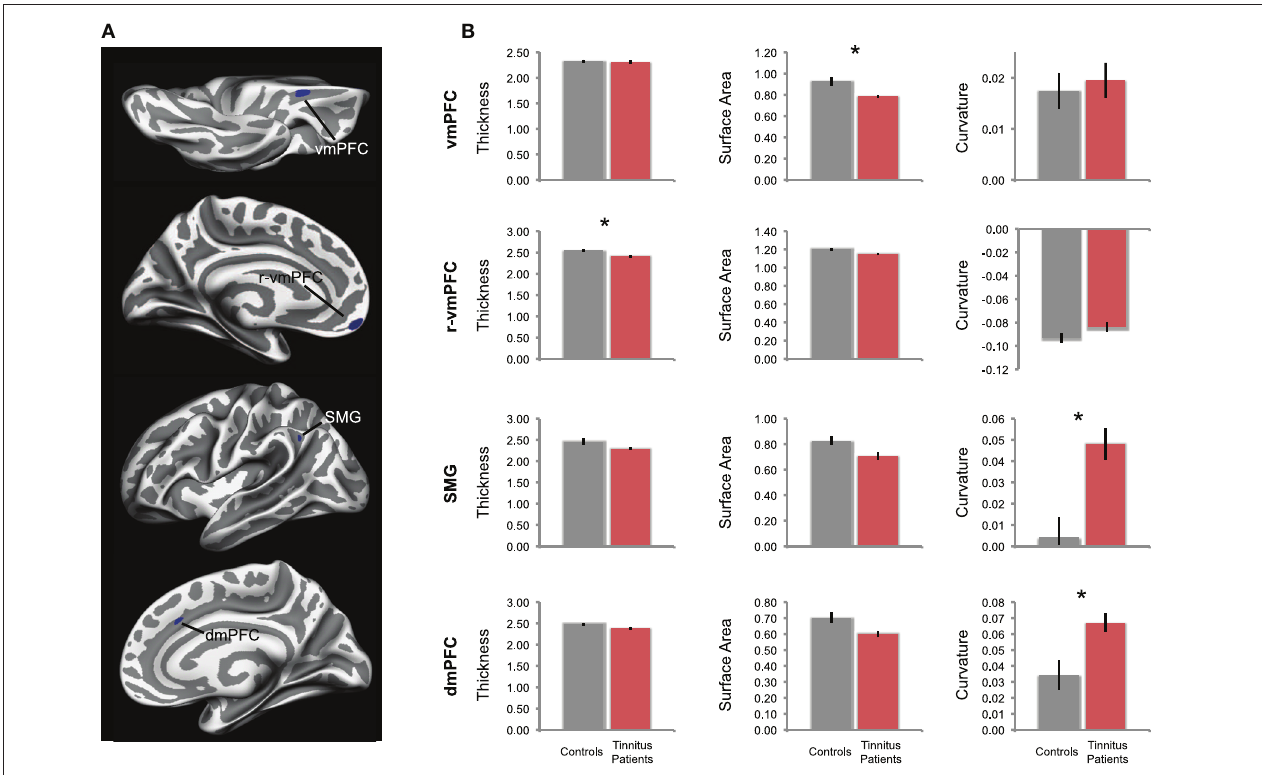
each cluster in (A) , the mean values of morphological features are plotted, including cortical thickness, surface area, and gyrification (curvature) for each group. For gyrification, positive values indicate sulci, negative values indicate gyri. Tinnitus patients are plotted in red; control participants are plotted in gray. Error bars represent standard error, and asterisks denote significant difference between groups ( p corr <